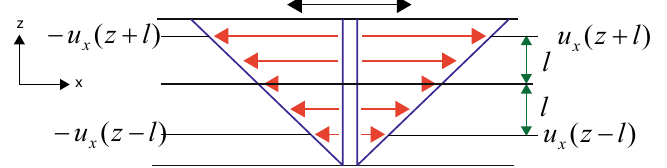
Figure 1. Transfer of momentum across a plane as a consequence of motion of molecules. The upper plane is periodically moved along the